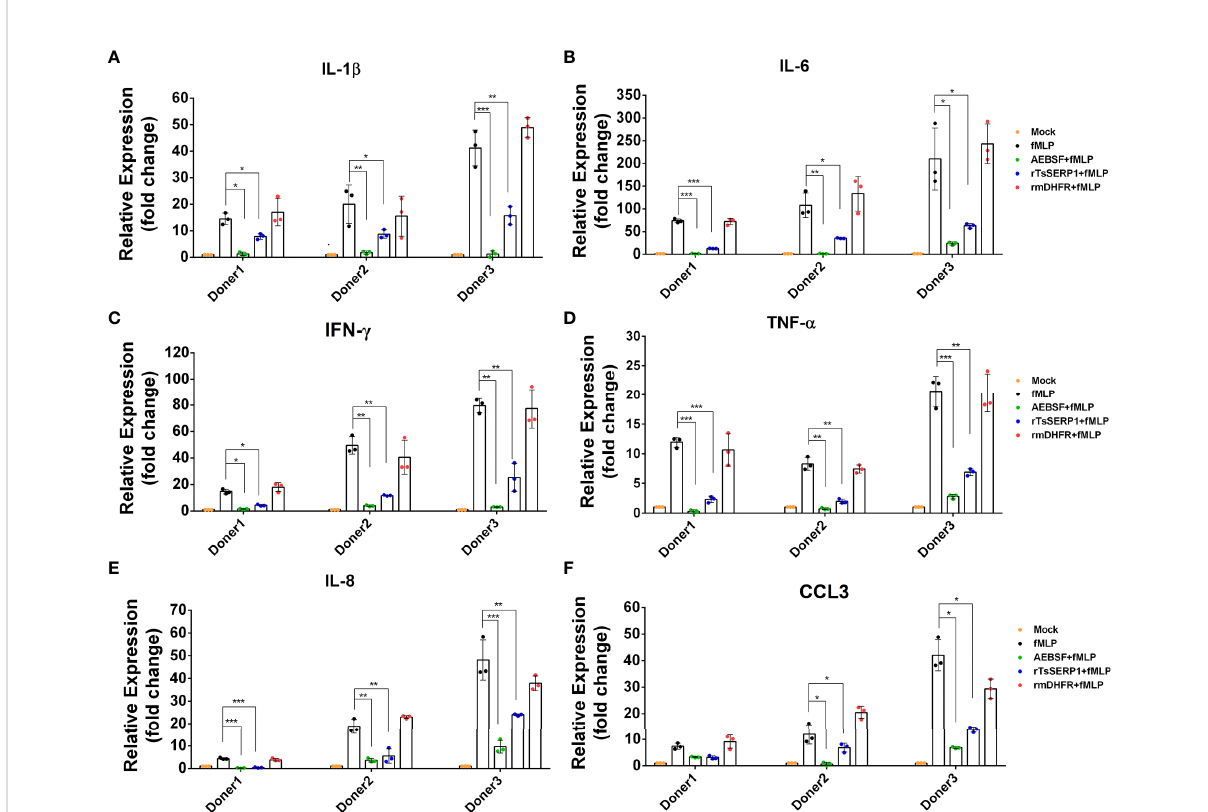
FIGURE 5 rTsSERP1 suppresses the transcription levels of cytokine and chemokine mRNAs in human neutrophils. Neutrophils were treated with 10 µg/ml of rTsSERP1 or an irrelevant control (rmDHFR) for 1 h prior and then stimulated with 100 nM of fMLP for 4 h. Thereafter, the cells were collected for RNA isolation and qRT-PCR analysis for IL-1 b (A) , IL-6 (B) , IFN- g (C) , TNF- a (D) , IL-8 (E) , and CCL3 (F) transcripts. The transcription level of each target was normalized to its own housekeeping gene level [glyceraldehyde 3-phosphate dehydrogenase (GAPDH)] and then compared with the untreated control (media only) to calculate the relative fold change. The bar charts show the data of three different donors. The results are presented as mean ± SD. The experiments were performed in triplicate with three independent experiments. One-way ANOVA followed by a Bonferroni multiple comparison test were used for statistical analysis: * p < 0.05, ** p < 0.01, and *** p < 0.001. The treatment conditions were included media alone (Mock), only fMLP induction (fMLP), fMLP induction and AEBSF treatment (AEBSF+fMLP), fMLP induction and